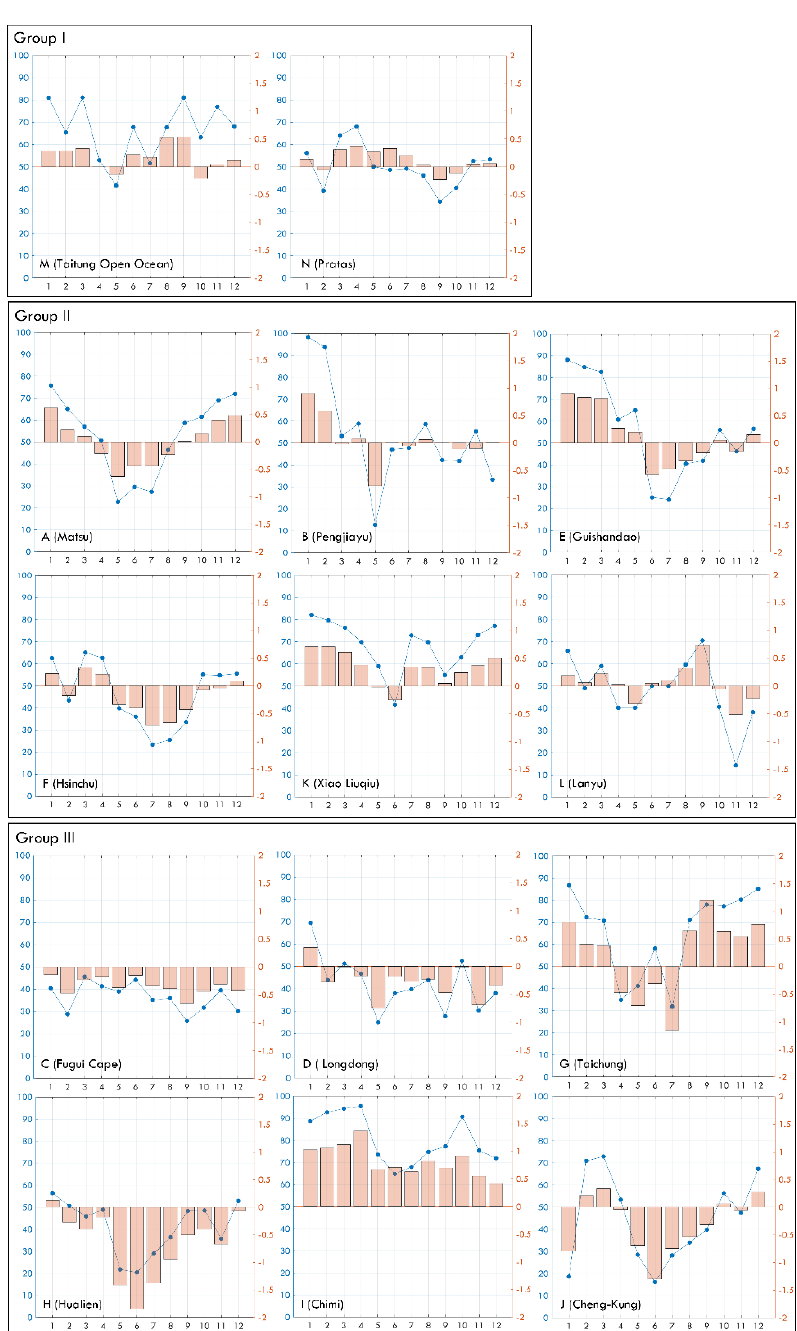
Figure A1. The difference between each buoy bulk SST and satellite skin SST in each month. The left vertical axis represents the percentage of data that bulk SST is greater than skin SST, and the right vertical axis represents the mean bias.